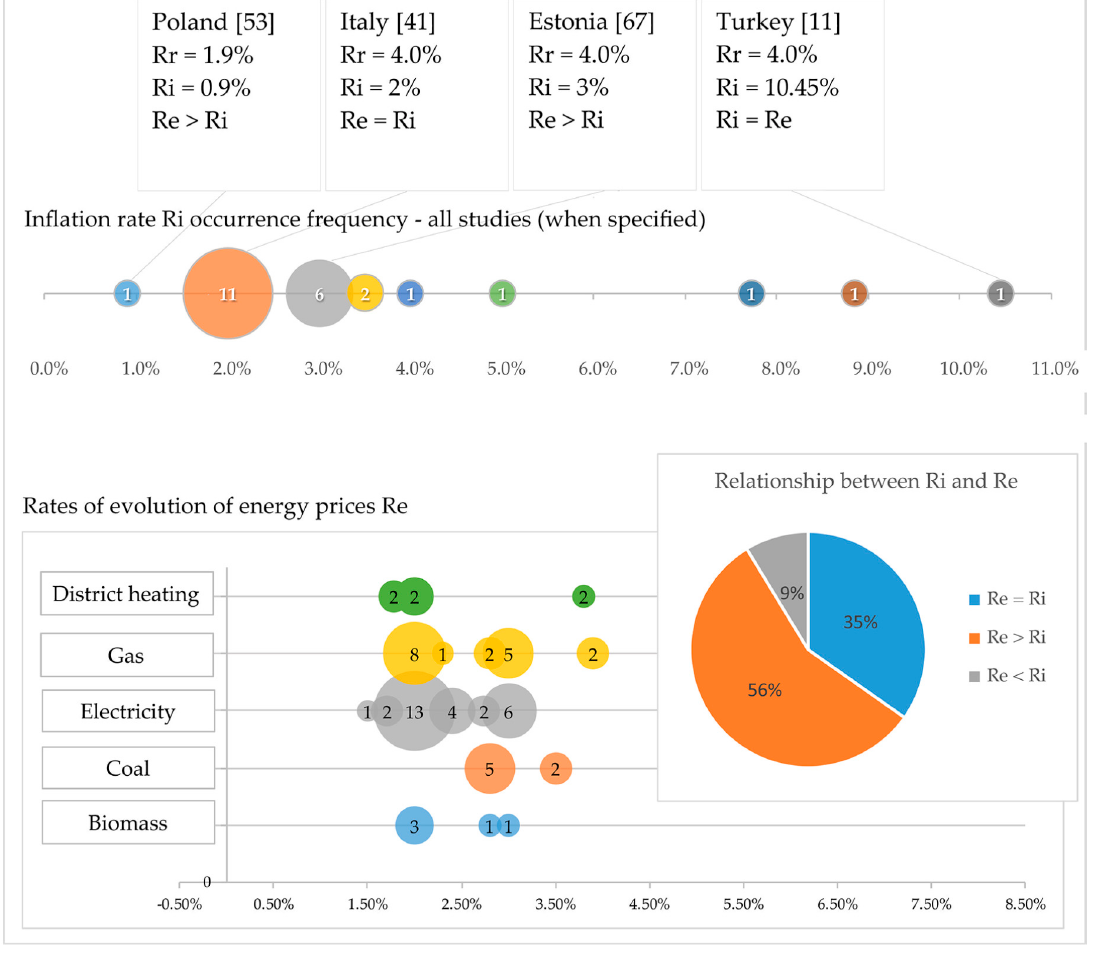
Figure 17. Analysis of inflation rate and of rates of evolution of energy prices and their relationship.